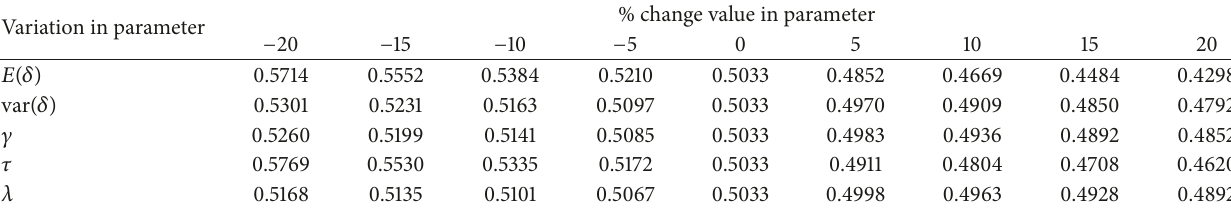
Table 6: Effects of changing four categories of parameters on Π 𝑇